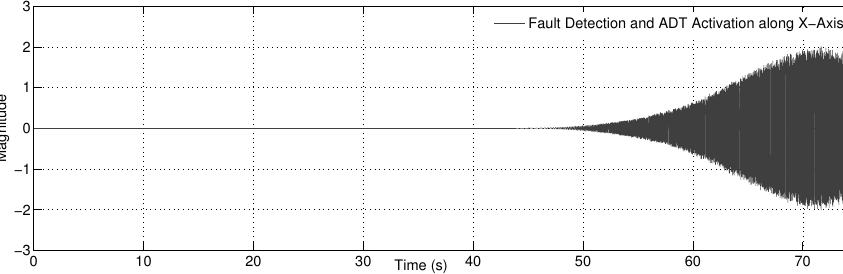
Figure 9. Drilling Tool vibration along the y-direction with induced fault.